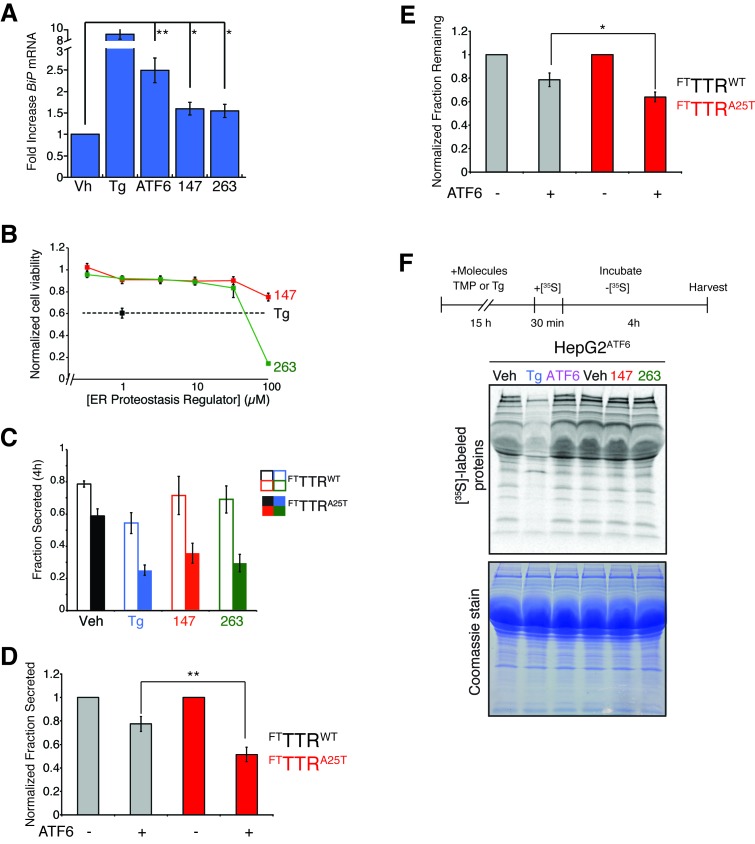
ER proteostasis regulators reduce secretion of destabilized amyloidogenic TTRA25T from HepG2 cells.(A) Plot showing the fold increase of BiP mRNA in HepG2ATF6 cells treated with Tg (1 µM), TMP (activates DHFR-ATF6; 10 µM) or 10 µM of the indicated small molecule ER proteostasis regulators. Error bars show standard error for n = 3. *p<0.05, **p<0.01. (B) Toxicity from 48 hr incubation of HepG2ATF6 cells with Tg (1 µM) or small molecules 147 or 263 at the indicated concentration as read by CellTiter-Glo. Error bars represent standard error from n = 6 replicates. (C) Quantification of the fraction FTTTRWT (open bars) or FTTTRA25T (colored bars) secreted following a 4 hr chase in HepG2ATF6 cells pretreated for 15 hr with Tg (1 µM; blue) or 10 µM small molecule 147 (red) or 263 (green). Fraction secreted was calculated using the equation: fraction secreted = [extracellular [35S]-TTR signal at t / (extracellular [35S]-TTR signal at t=0 + intracellular [35S]-TTR signal at t=0)]. Representative autoradiograms are shown in Figure 5A. Error bars show standard error for n = 4 replicates. (D) Quantification of normalized fraction secreted of FTTTRWT (grey) or FTTTRA25T (red) from HepG2ATF6 cells following 15 hr pretreatment with TMP (10 µM; activates DHFR-ATF6). Fraction secreted was calculated using the equation: fraction secreted = [extracellular [35S]-TTR signal at t / (extracellular [35S]-TTR signal at t=0 + intracellular [35S]-TTR signal at t=0)]. Normalized fraction secreted was calculated relative to vehicle-treated controls using the equation: normalized fraction secreted = fraction secreted treatment / fraction secreted vehicle. Error bars show standard error for n = 9. **p<0.01. (E) Quantification of normalized fraction remaining of FTTTRWT (grey) or FTTTRA25T (red) from HepG2ATF6 cells following 15 hr pretreatment with TMP (10 µM; activates DHFR-ATF6). Fraction remaining was calculated using the equation: [(extracellular [35S]-TTR signal at t + intracellular [35S]-TTR signal at t) / (extracellular [35S]-TTR signal at t=0 + intracellular [35S]-TTR signal at t=0)]. Normalized fraction remaining was calculated relative to vehicle-treated controls using the equation: normalized fraction remaining = fraction remaining treatment / fraction remaining vehicle. Error bars show standard error for n = 9. *p<0.05. (F) Representative autoradiogram and Coomassie images of total [35S]-labeled protein secreted from HepG2ATF6 cells following 15 hr pretreatment with 1 µM Tg, TMP (10 µM)-dependent DHFR-ATF6 activation, or 10 µM small molecule ER proteostasis regulators 147 or 263. The experimental protocol used for this experiment is shown above. Quantification of this experiment is shown in Figure 5D.